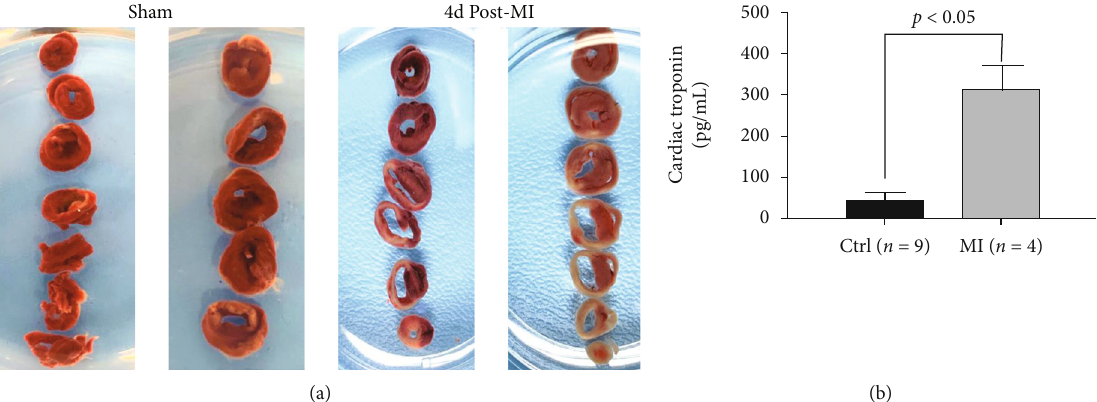
Figure 5: Validation of MI model. (a) TTC-stained slices of sham and MI hearts. MI hearts showed signi fi cant thinning of the ventricular wall and large areas of unstained necrotic tissue. (b) Cardiac troponin levels in plasma from sham control versus MI